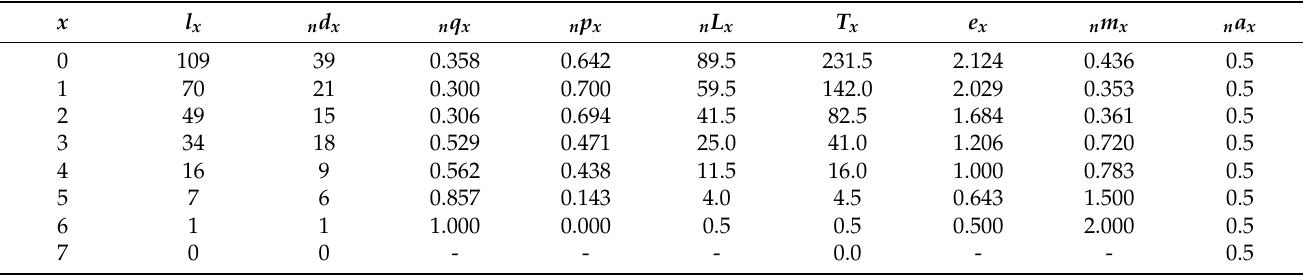
Table 4. An empirical life table for female hedgehogs. Nomenclature follows Jones [73]: x: the exact age at the start of the interval; n : the length of the interval in person-years (the difference between the values of x in consecutive rows); l x : the number of individuals entering the interval at age x , with the first entry being the number of individuals in the entire cohort and subsequent entries being the number surviving to each age ( x ); n d x : the number of individuals dying between ages x and x + n ; n q x : the probability of dying, calculated as n d x / l x ; n p x : the probability of surviving, calculated as 1 − ( n d x / lx ); n L x : person-years lived between ages x and x + n ; T x : person-years lived above age x ; e x : life expectancy from age x ; n m x : death rate in the cohort between ages x and x + n ; n a x : the average number of years lived in the time interval by those dying in the time interval, was assumed to be 0.5